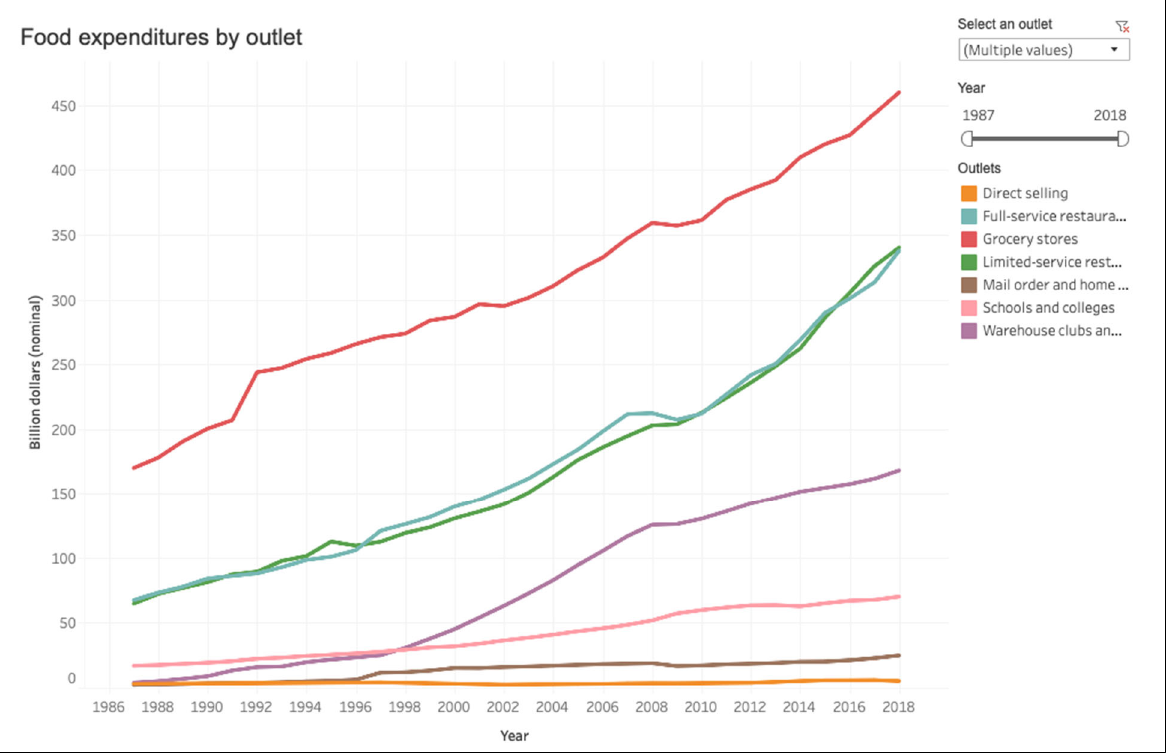
Figure 1. U.S. Food Expenditures by Outlet, 1987–2018